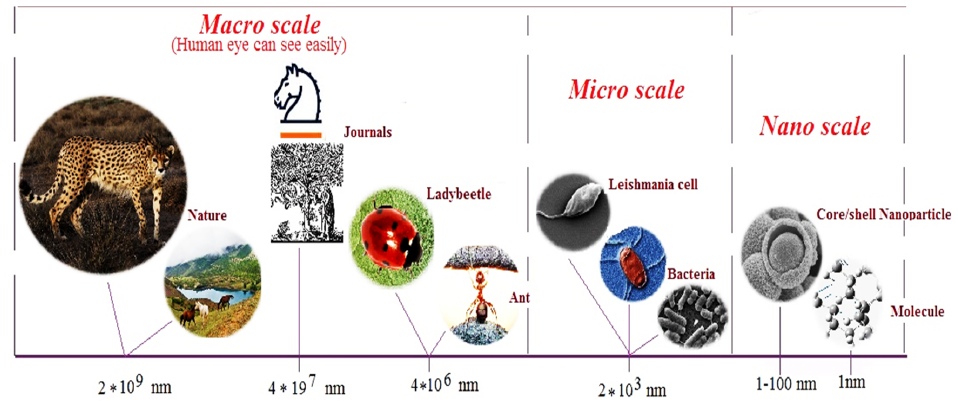
Figure 1. Comparison of macro, micro, and nano scales.